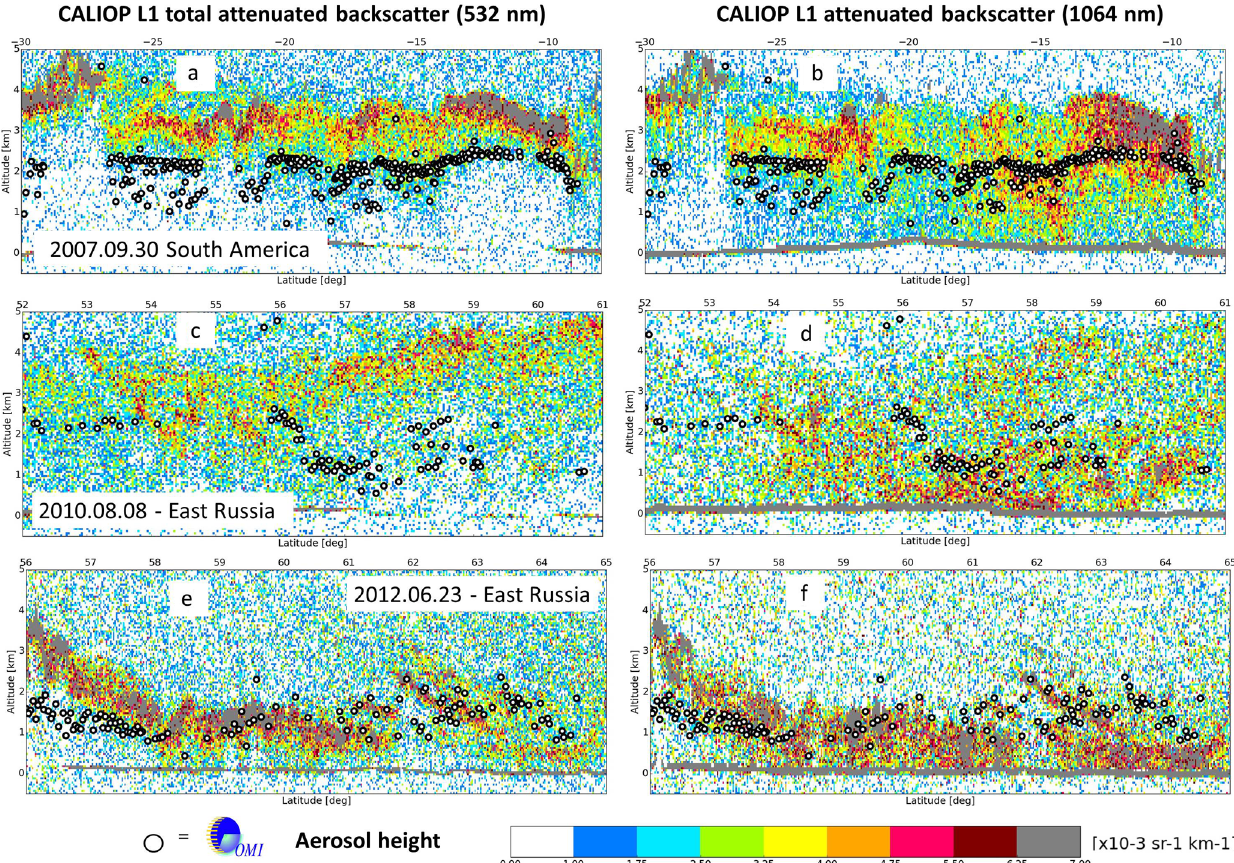
Figure 8. Retrieved OMI ALH compared with CALIOP L1 along-track vertical profile observations (532 and 1064nm) for biomass burning cases: (a, b) 30 September 2007 in South America, (c, d) 8 August 2010 in eastern Russia, and (e, f) 23 June 2012 in eastern